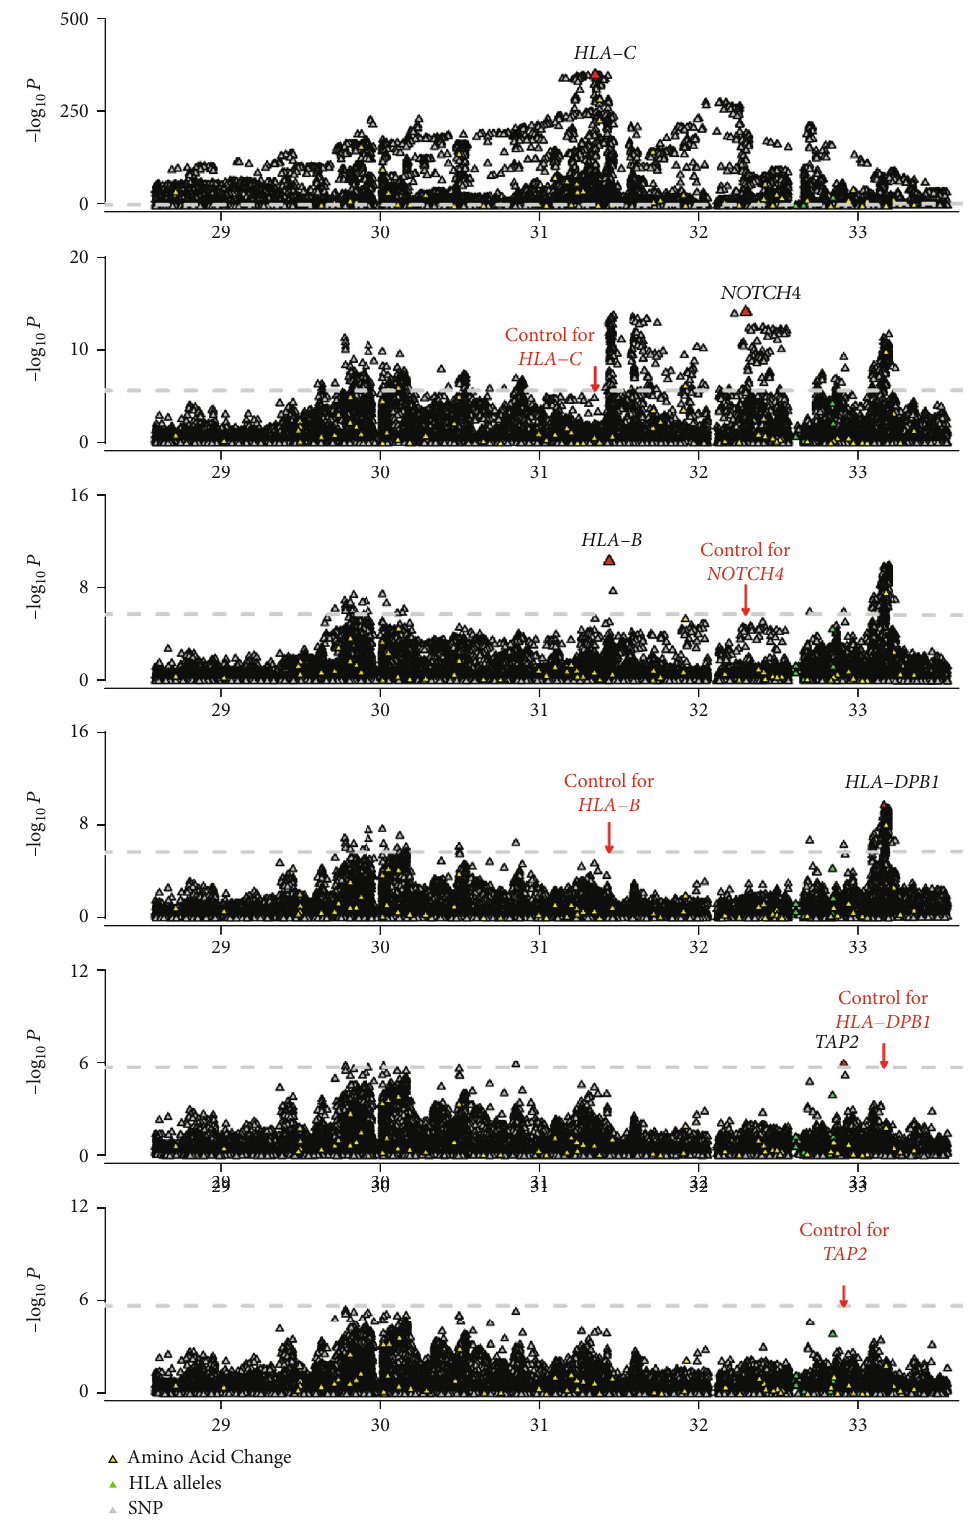
Figure 1: A Manhattan plot of the stepwise conditional association for psoriasis with a family history (PFH) in the major histocompatibility complex (MHC) region. Stepwise analysis of HLA-C , NOTCH4 , HLA-B , HLA-DPB1 , and TAP2 in PFH vs. control. For each plot, the horizontal axis shows the genomic position, and the vertical axis shows negative log -transformed P values for association. The dashed 10 horizontal line corresponds to the signi fi cance threshold of P = 1 : 87 × 10 − 6 . The red triangles represent the top associated